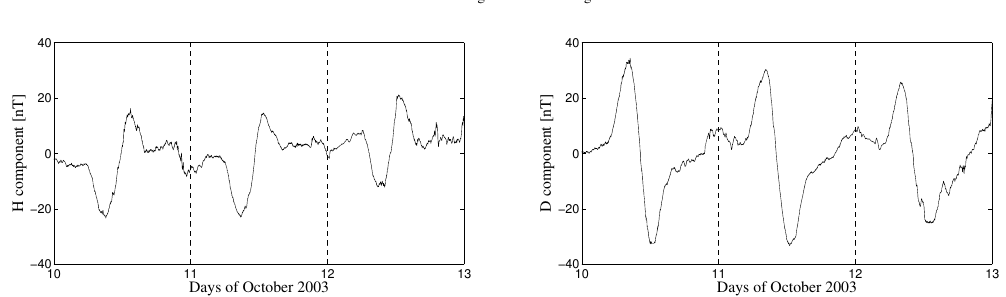
Figure 1. SSQ, 10–12 October 2003: midlatitude ground observations (AQU: λ g = 42 . 38 ◦ N and φ g = 13 . 32 ◦ E) for the H (left panel) and D (right panel) components. The time resolution is